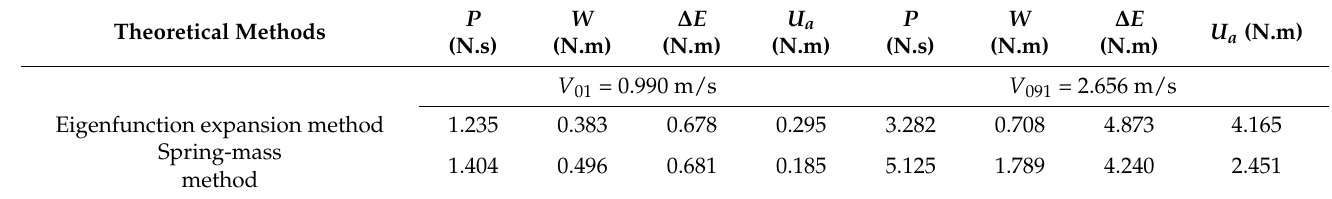
Figure 11. Contact force-Indentation relations by eigenfunction expansion method and spring-mass method (with Thornton contact model): ( a ) the 1st impact, V 01 = 0.990 m/s; ( b ) the 91st impact, V 091 = 2.656 m/s. Table 5. Impulse ( P ), contact work ( W ), energy absorption of the beam ( Ua ) and kinetic energy loss of the sphere ( ∆ E ) of eigenfunction method and spring-mass method for the first and 91st repeated